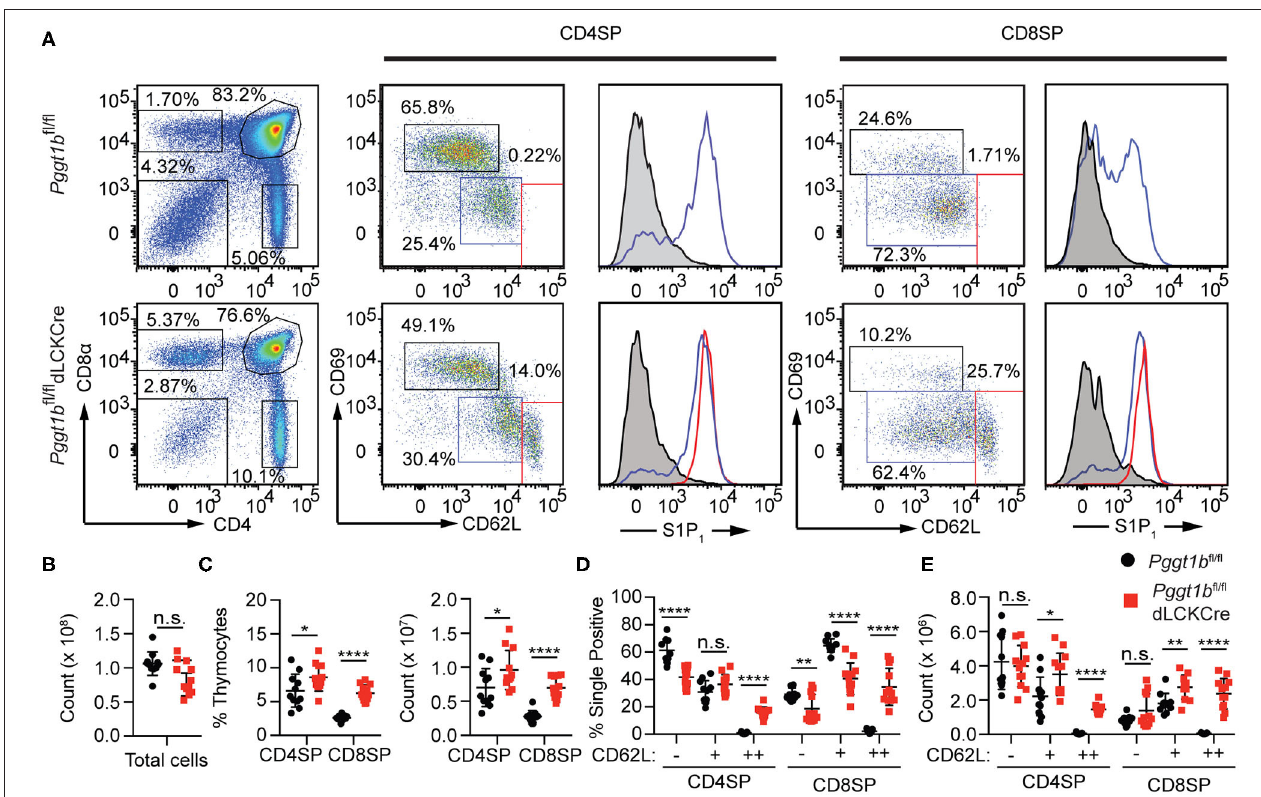
FIGURE 1 | Defective mature thymocytes egress in Pggt1b fl / fl dLckCre mice (A) Flow cytometry analysis of thymic CD4 SP and CD8 SP cell expression of CD69 and CD62L and the expression of S1P1R based on sub-populations defined by CD62L low CD69 high , CD62L, and CD69 intermediate or CD62L high CD69 low ; (B) Total number of thymocytes; (C) the percentage and number of CD4 SP and CD8 SP of total thymocytes; (D) percentage and the total number of CD4 SP and CD8 SP subpopulations described in (A) . Each dot in the graphs (B–E) represents a single mouse (n.s. statistically not significant; * p < 0.05, ** p < 0.01, *** p < 0.001, **** p < 0.0001, unpaired t